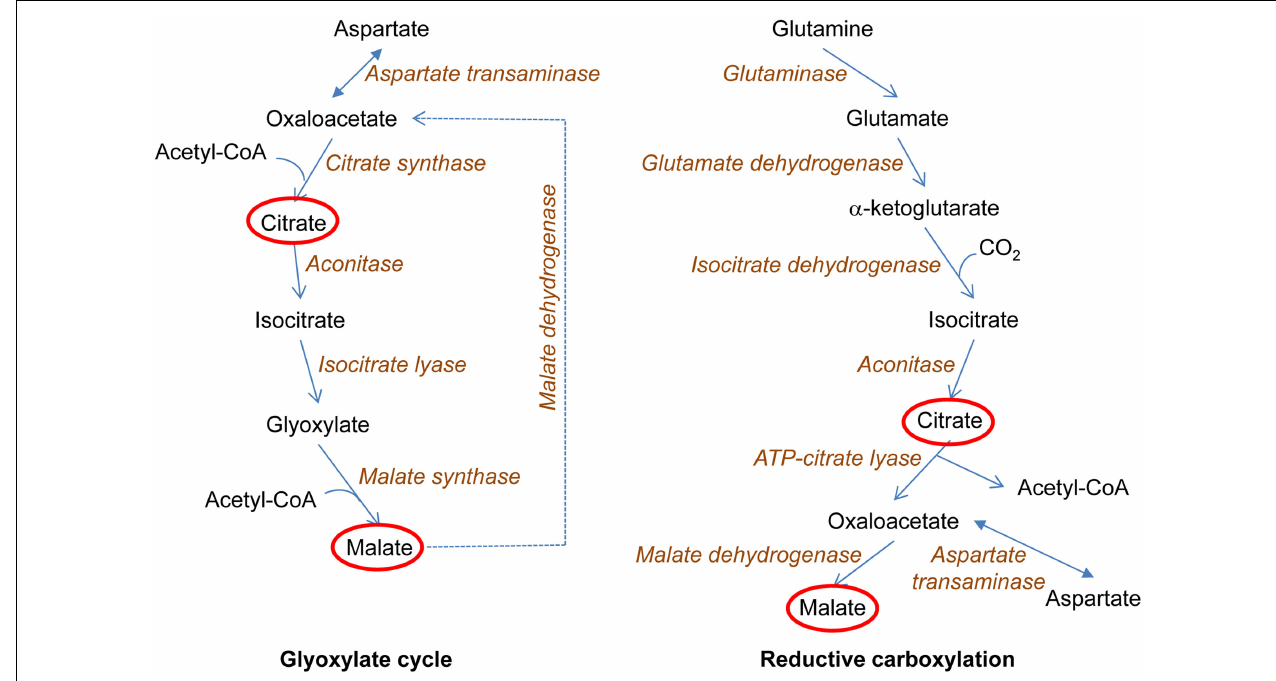
FIGURE 4 | Metabolic adaptations to loss of biosynthetic intermediate production by a truncated tricarboxylic acid (TCA) cycle. The loss of the electron transport chain interrupts theTCA cycle at the succinate dehydrogenase reaction.This prevents the utilization of theTCA cycle for production of biosynthetic intermediates. In yeast, the glyoxylate cycle is induced.This allows acetyl-coenzyme A (acetyl-CoA) to be used for the synthesis of theTCA cycle metabolites citrate and malate, in reactions that conserve the two carbons of acetate.This, in turn, allows the first three reactions of theTCA cycle to proceed with the synthesis of α